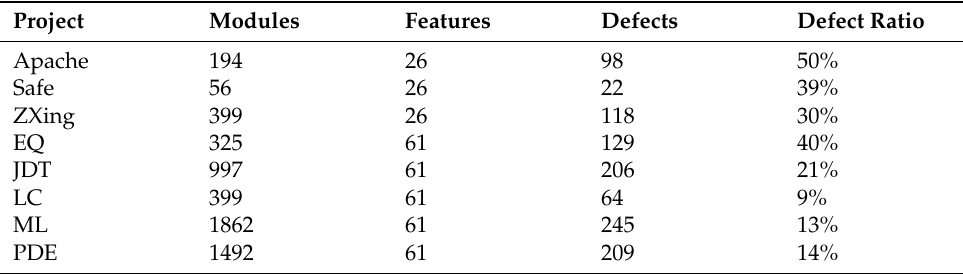
Table 1. Experimental